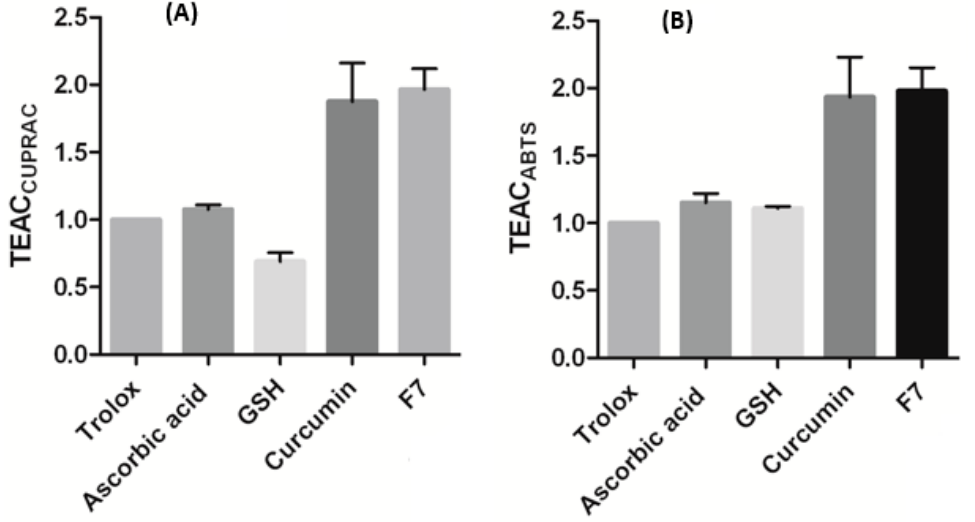
Figure 9. Antioxidant capacity of standard antioxidants (ascorbic and reduced glutathione (GSH)) compared with curcumin powder and curcumin insert (F7) using Cupric reducing antioxidant capacity (CUPRAC) ( A ) and Trolox equivalent assays ( B ), data represent means ± SD, n = 3.